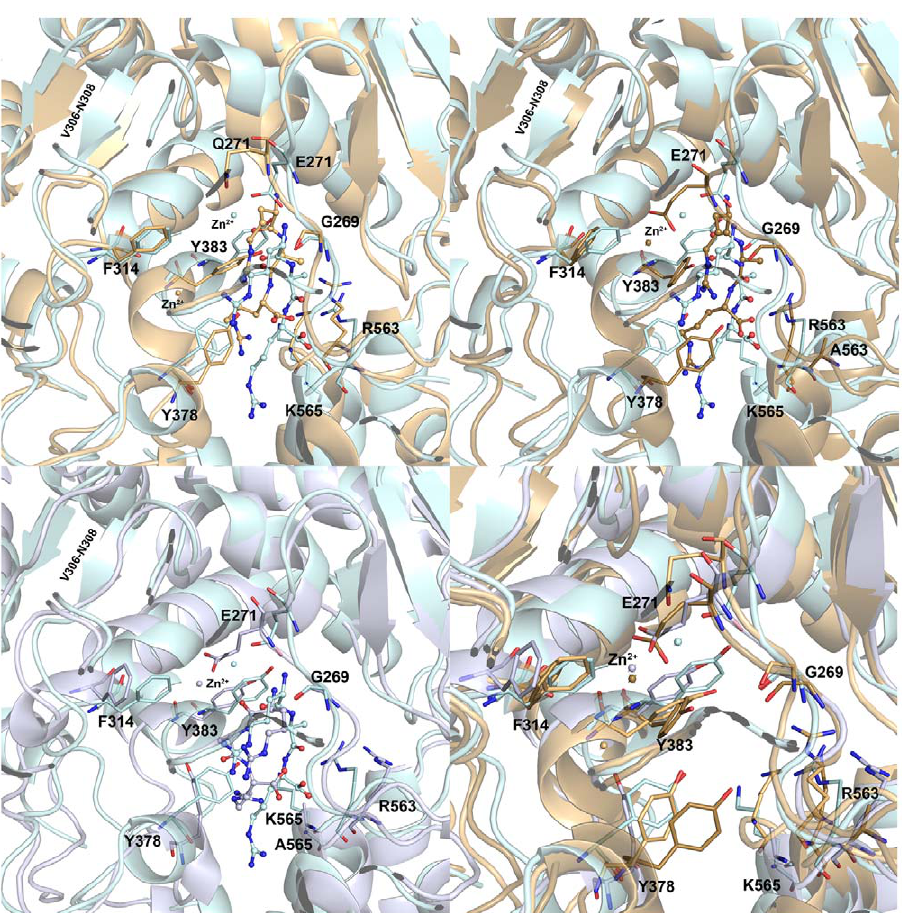
Figure 10. Overlay of WT and mutant systems of L-RAR complexes to observe the structural changes. (A) WT and E271Q systems, (B) WT and R563A systems, (C) WT and K565A systems, and (D) all L-RAR systems. The WT, E21Q, R563A, and K565A systems are shown in grey, wheat, deep teal, and pink colors, respectively. The amino acid residues and RAR are shown in think stick and ball-stick forms, respectively. The metal ion (zinc) present at the active site is shown in sphere